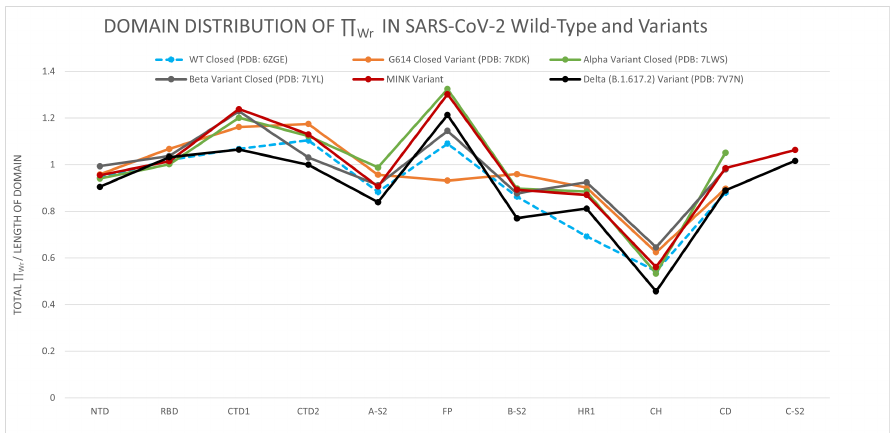
Figure 4. The distribution of the total local topological free energy in the SARS-CoV-2 Spike protein domains for the WT and variants in closed